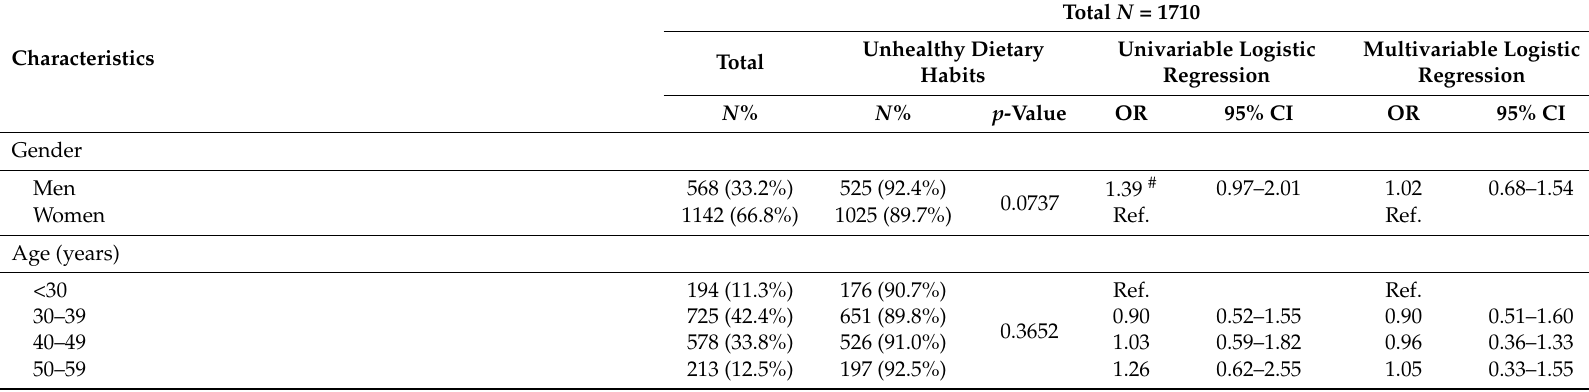
Table 6. Odds ratios (ORs) and 95% confidence intervals (CIs) for unhealthy dietary habits by sociodemographic characteristics.